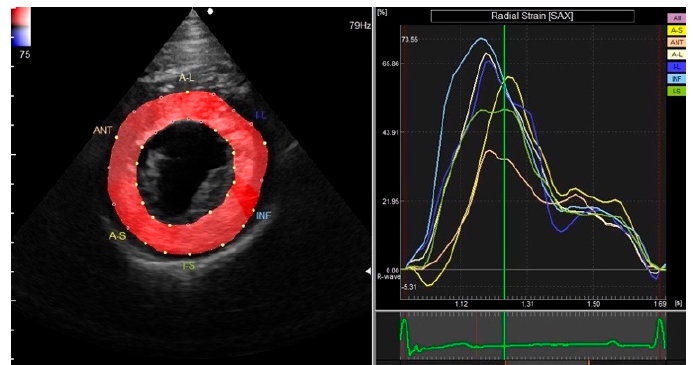
Figure 1. Global peak strain in the radial direction obtained via right parasternal short-axis view at the level of the papillary muscle.